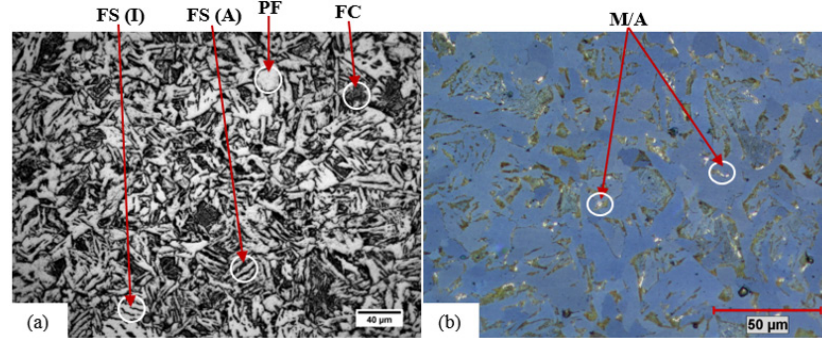
Figure 5: Optical microstructure characterization of CGHAZ for S-SAW. (a) 2% Nital etching and (b) Klemm I etching.